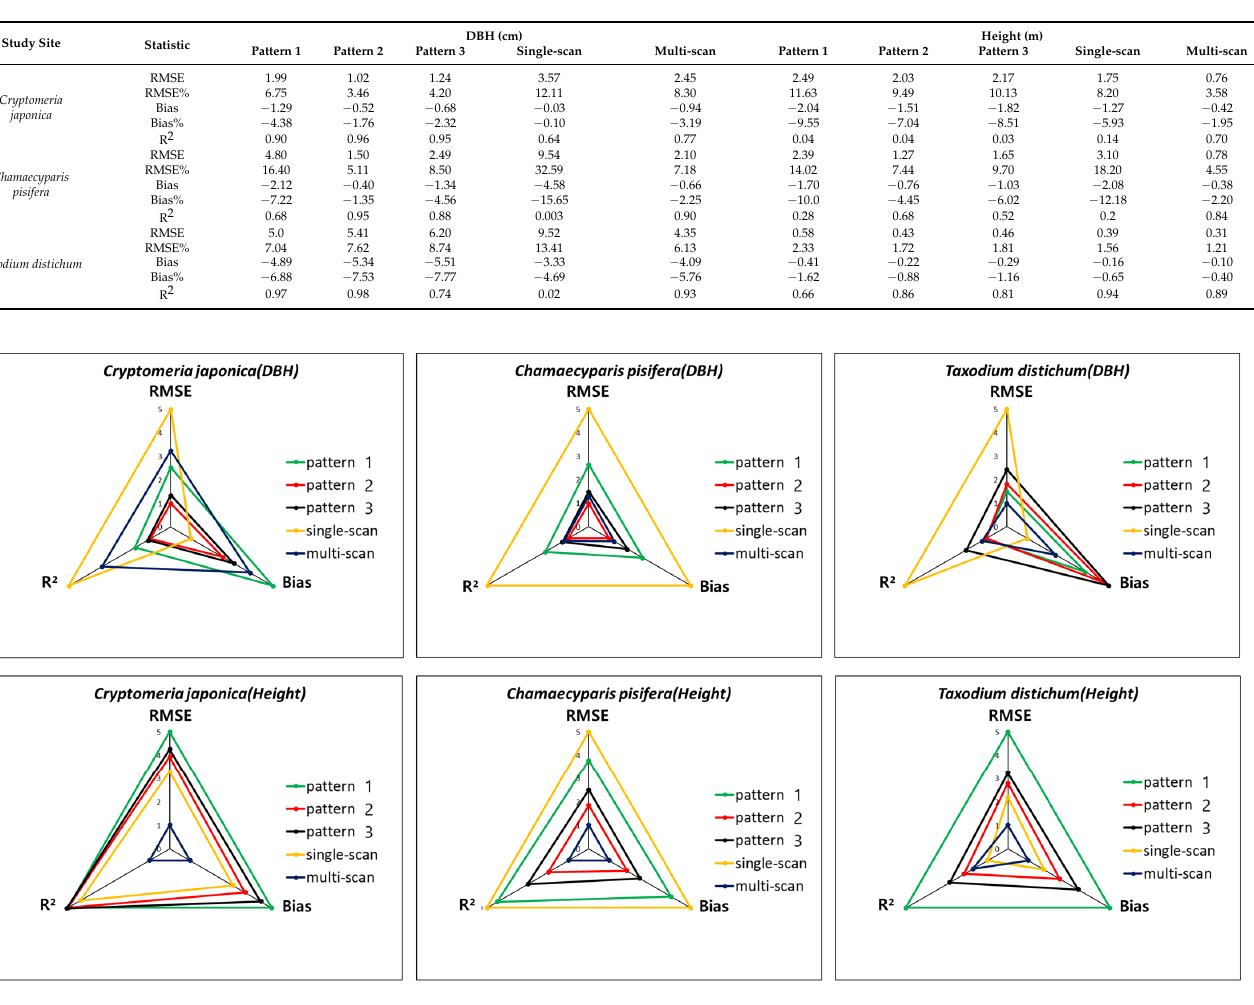
Table 7. Comparative accuracy assessment of the obtained DBH and vegetation height data using the BPLS and TLS by pattern.